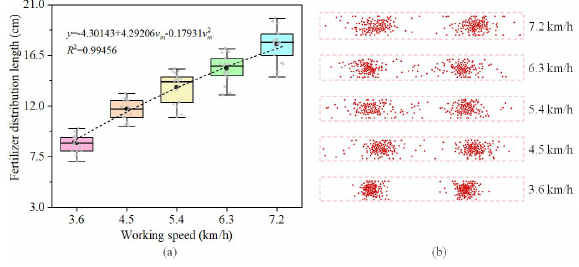
Fig. 5. Variation of the performance of the fertilizer particles distribution with the working speed.